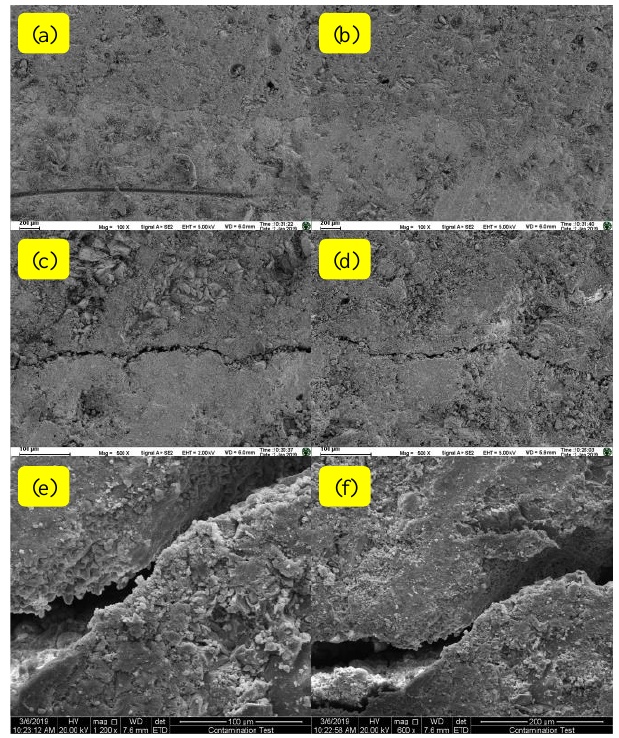
Figure 16. Scanning electron microscopy (SEM) images: ( a ) and ( b ) Original interface, ( c ) and ( d ) 100 freeze-thaw cycles, ( e ) and ( f ) 28 days’ immersion in hot water.